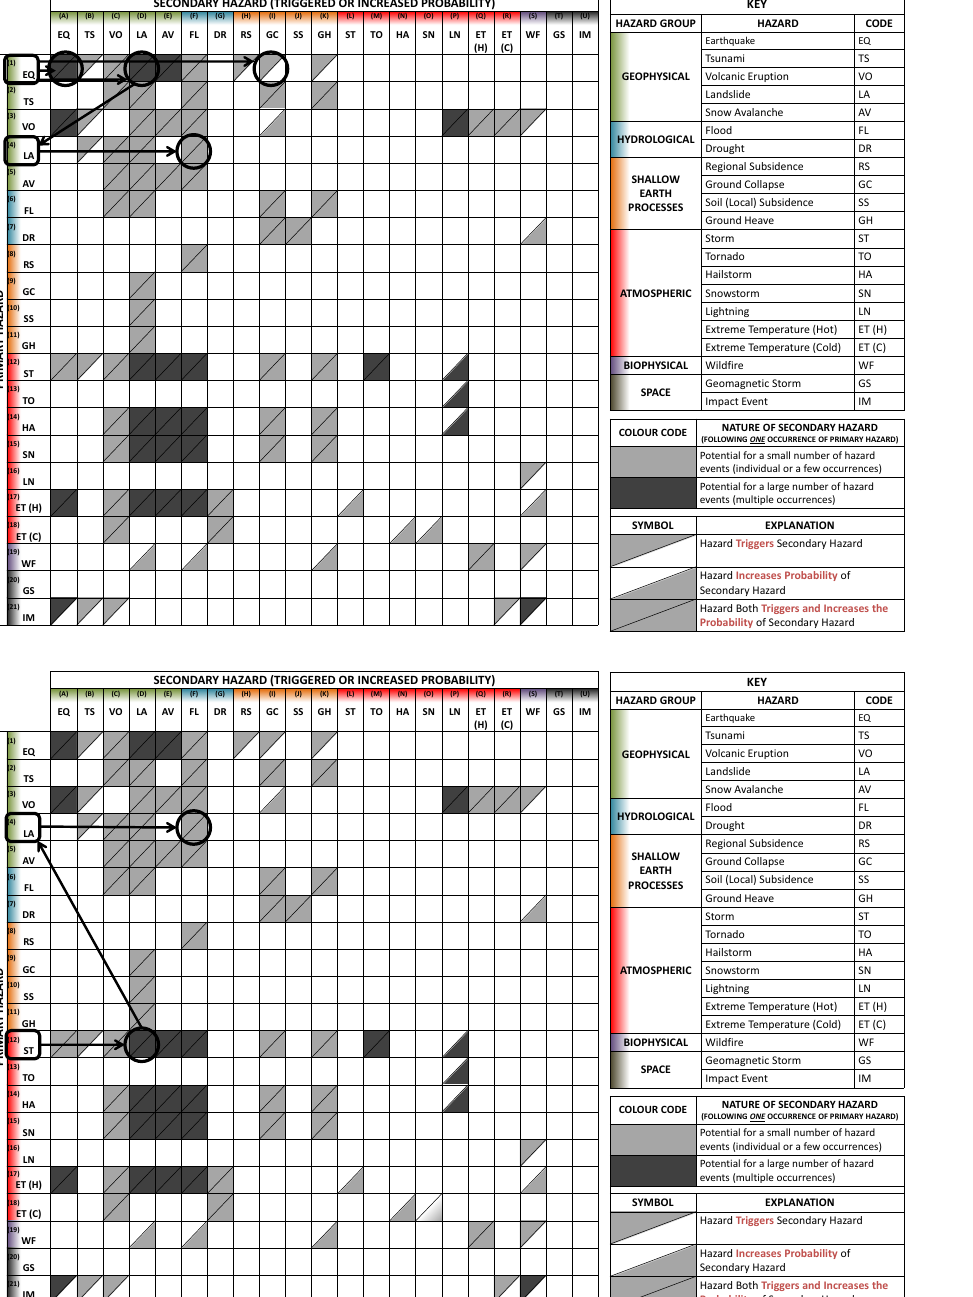
Figure 5. Two examples of networks of hazard interactions (cascade systems) using a hazard interaction matrix. Hazard interaction networks based on (top) the 1976 Guatemala earthquake sequence and (bottom) lahar-triggered flooding associated with Santiaguito, Guatemala. Both network examples are placed on a 21 × 21 hazard interaction matrix, adapted from Gill and Malamud (2014), and described in detail within the caption of Fig. 4. In the top example (described in Sect. 5.2), based on information from Espinosa (1976), Plafker et al. (1976) and Harp et al. (1981), we use rectangles, circles and arrows to illustrate the network of hazard interactions for an earthquake (EQ) triggering further earthquakes (EQ), landslides (LA) and rapid subsidence/ground collapse (GC). The landslides (LA) were then noted to have blocked rivers, causing flooding (FL). The bottom network of hazard interactions example (also described in Sect. 5.2) is based on information from Harris et al. (2006) and confirmed by personal field observations and seven semi-structured interviews with hazard monitoring and civil protection officials while the authors were in Guatemala in 2014. The bottom example shows (again using rectangles, circles and arrows) rain storms (ST) triggering lahars (LA) on the flanks of Santiaguito. These lahars enter the hydrological system and result in flooding (FL)